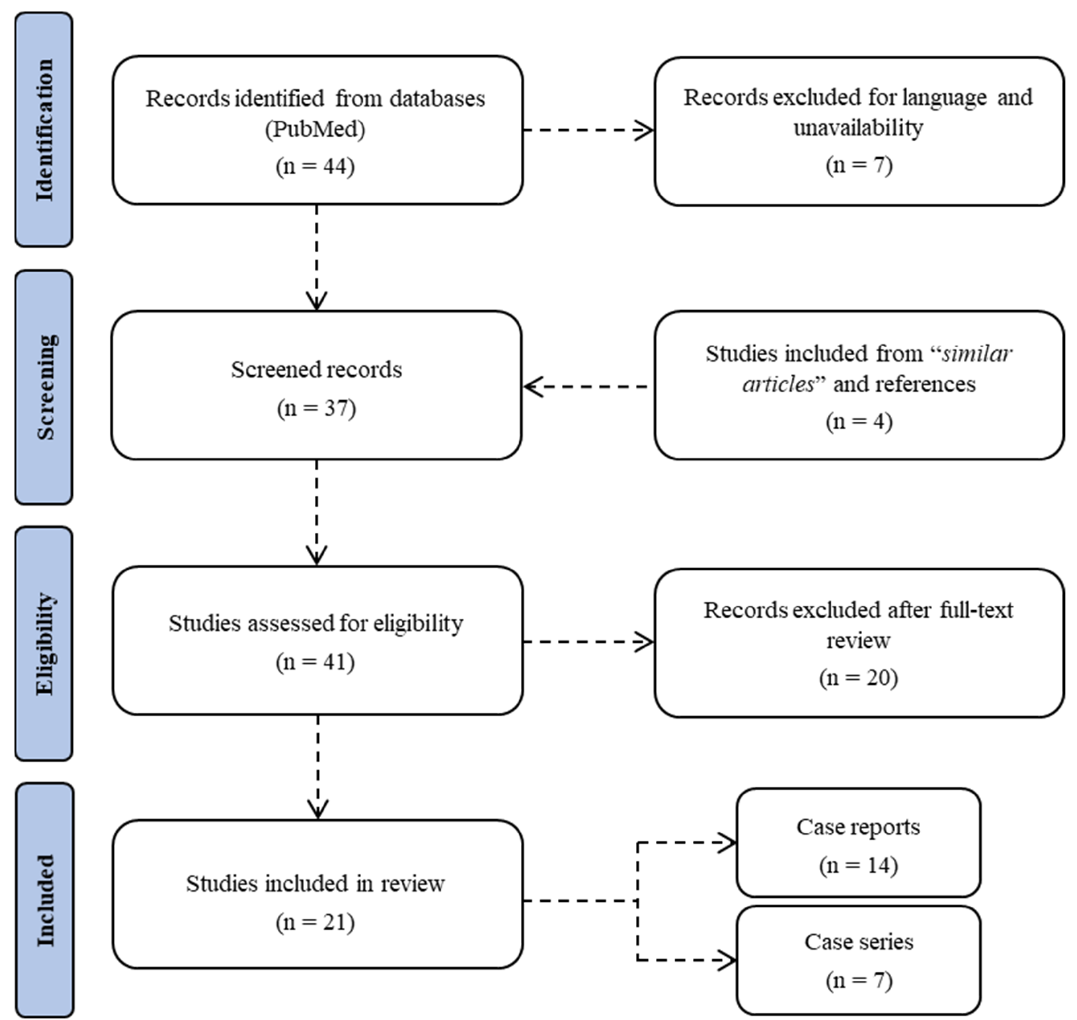
Figure 1. Flow chart of the systematic literature search according to PRISMA 2020 guidelines.